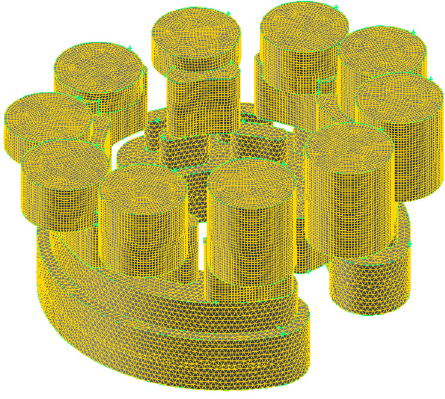
Figure 10. Mesh of the flow field.